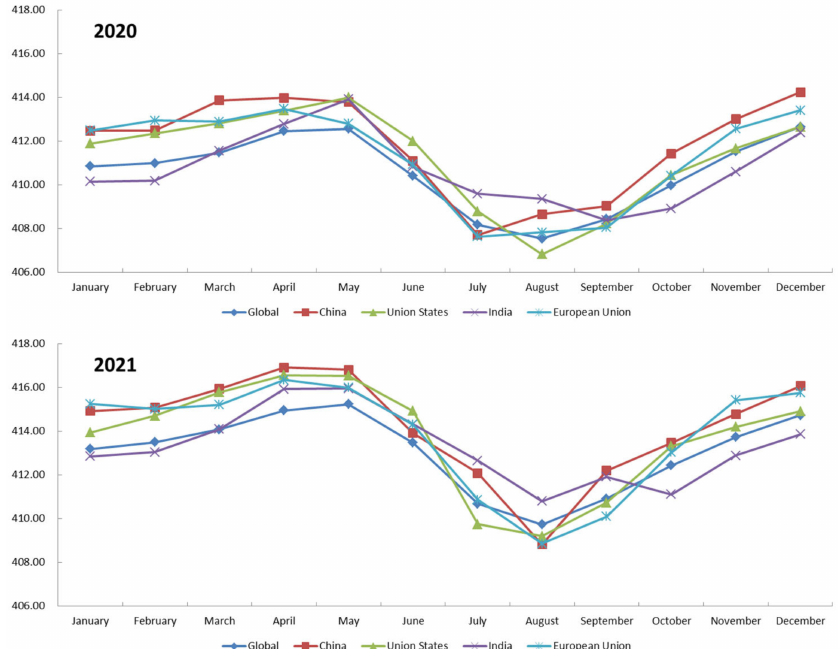
Figure 4. Global land and major country monthly trends of CO 2 concentrations in 2020 and